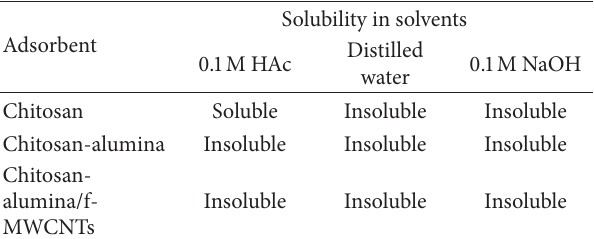
Table 2: Solubility effect of chitosan and chitosan-based nanocom-